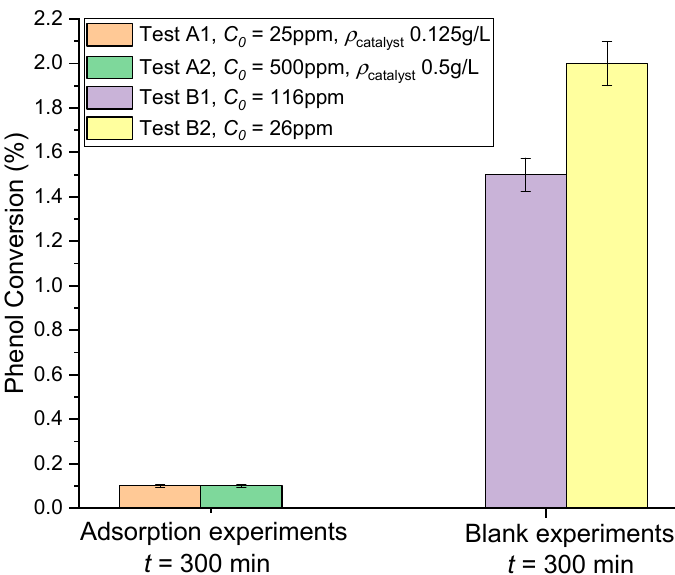
Figure 4. Phenol adsorption (without UV irradiation) and blank (without catalyst but with UV irradiation) experiments, all conducted at T = 40 °C and pH = 7.